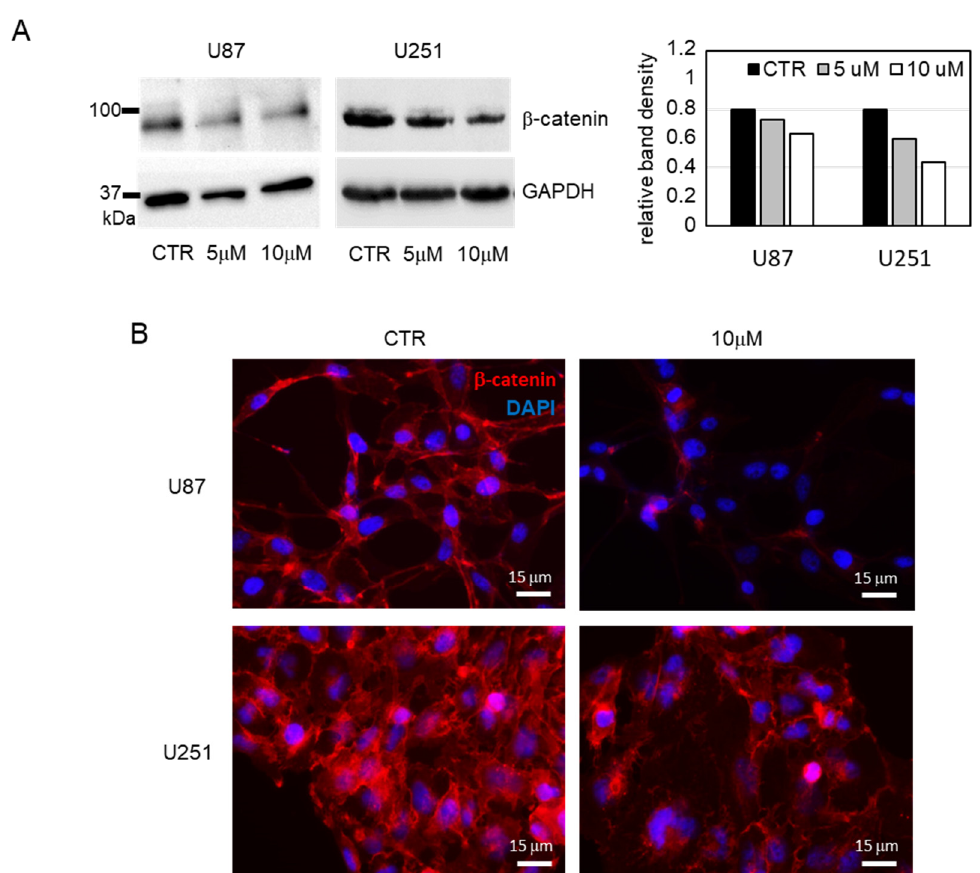
Figure 7. Expression of β -catenin protein in GBM U87 and U251 cells treated with BA103 . ( A ) β -catenin expression was analyzed by Western blot in the cell lysate of GBM cells treated for 48 h with 1 and 10 μ M BA103 . The expression level of GAPDH is shown as the loading control, and the analysis of relative band density is reported in the histogram on the right. Detailed information about Western blot can be found in the Supplementary Materials (Figure S3). ( B ) β -catenin expression was analyzed by immunofluorescence in GBM U87 and U251 treated with 10 μ M BA103 for 48 h. Nuclei were stained with DAPI. Images were acquired by fluorescence microscope at 400× magnification.